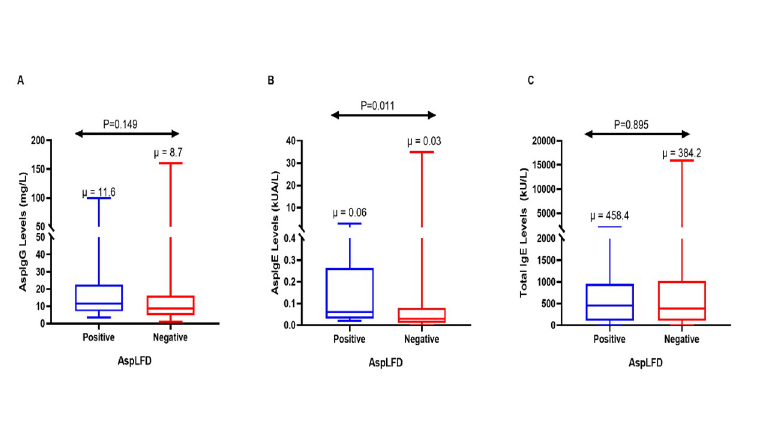
Fig 1. Distribution of levels of Asp IgG (A), Asp IgE (B) and Total IgE (C) in patients with a positive or negative LFD. μ -